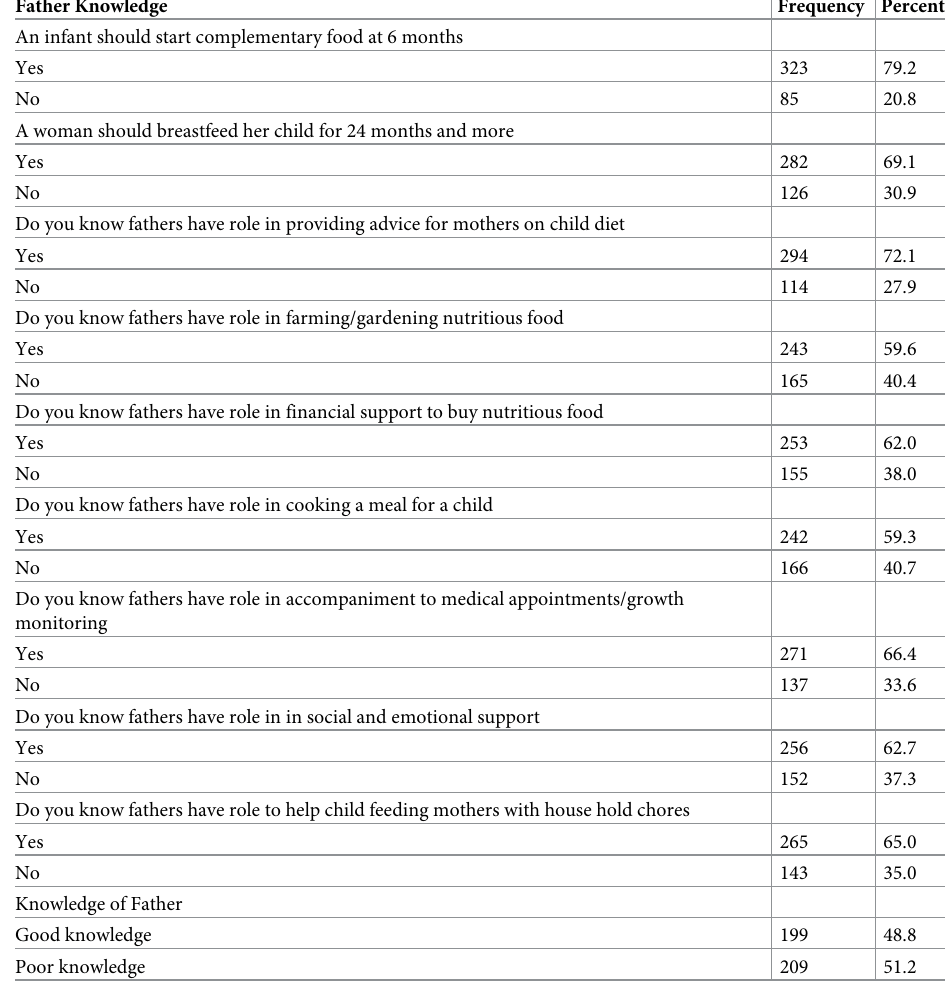
Table 2. Knowledge of fathers about father involvement in child feeding in Antsokia Gemza Woreda, 2022. Father